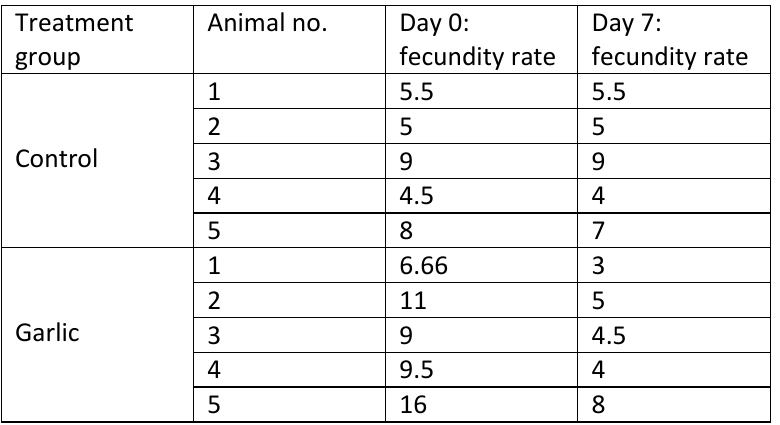
Animal no. Day 0: